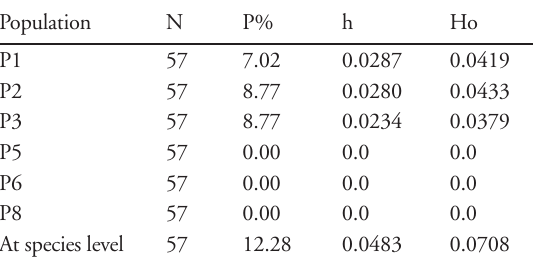
Table 4. Genetic diversity within populations of E. andevalensis from Spain and Portugal. N = total number of usable loci, P% = percentage of polymorphism, h = Nei’s gene diversity and Ho = Shannon’s index.